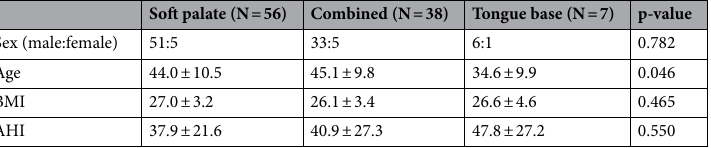
Table 1. Obstructive pattern with drug-induced sleep fluoroscopy. BMI body mass index, AHI apnea– hypopnea index.